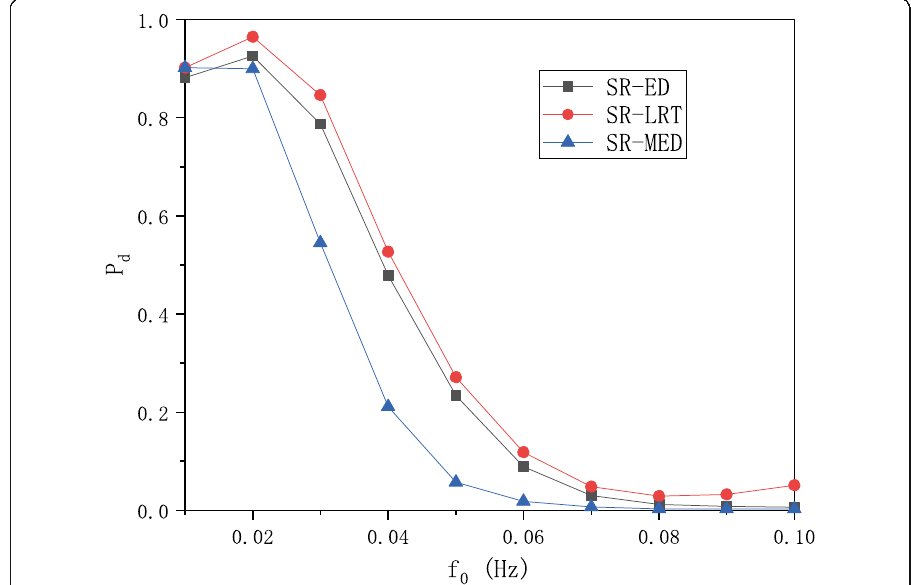
Fig. 5 The detection probability P d versus normalized frequency f 0 with